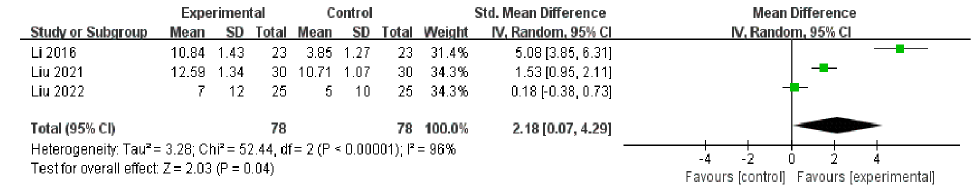
Figure 6. Artificial tears vs. Auricular acupressure on SIT [47–49]. SOS An RCT [48] ( n = 46) used SOS as a measure to test the effect of auricular acupressure on the severity of symptoms in dry eye disease patients. Compared to artificial tears, au- ricular acupressure had positive effects in reducing the severity of symptoms in patients with dry eye diseases [M D = −1 1.5, 95% CI ( −1 3.68, −9 .32), p < 0.01]. OSDI An RCT [49] ( n = 50) used OSDI as a measure to examine the effect of auricular acu- pressure on general ocular-related symptoms for dry eye disease patients. Compared to artificial tears, auricular acupressure had no significant effects in improving OSDI for pa- tients with dry eye diseases [M D = −8 .22, 95% CI ( −1 6.90, 0.46), p = 0.06]. 3.3.2. Artificial Tears vs. Auricular Acupressure plus Artificial Tears TBUT There were two RCTs [51,52] ( n = 180) in which TUBT was used as a measurement of the effects of auricular acupressure on dry eye disease patients. Meta-analysis suggested that compared to artificial tears alone, auricular acupressure plus artificial tears had a favora- ble effect on improving tear-film stability in patients with dry eye disease. [MD = 1.21, 95% CI (0.73, 1.68), p < 0.001, with low heterogeneity: Chi 2 = 0.00, p = 0.97, I 2 = 0%] (Figure 7). Figure 7. Artificial tears vs. Artificial tears plus Auricular acupressure on TBUT [51,52]. SIT There were two RCTs [51,52] ( n = 180) in which SIT was used as a measurement of the effects of auricular acupressure on dry eye disease patients. The meta-analysis sug- gested that, compared to artificial tears alone, auricular acupressure plus artificial tears had a favorable effect on increasing the quantity of tear secretion of dry eye disease pa- tients. [MD = 2.40, 95% CI (1.62, 3.18), p < 0.001, with low heterogeneity: Chi 2 = 1.11, p = 0.29, I 2 = 10%] (Figure 8). Figure 8. Artificial tears vs. Artificial tears plus Auricular acupressure on SIT [51,52].